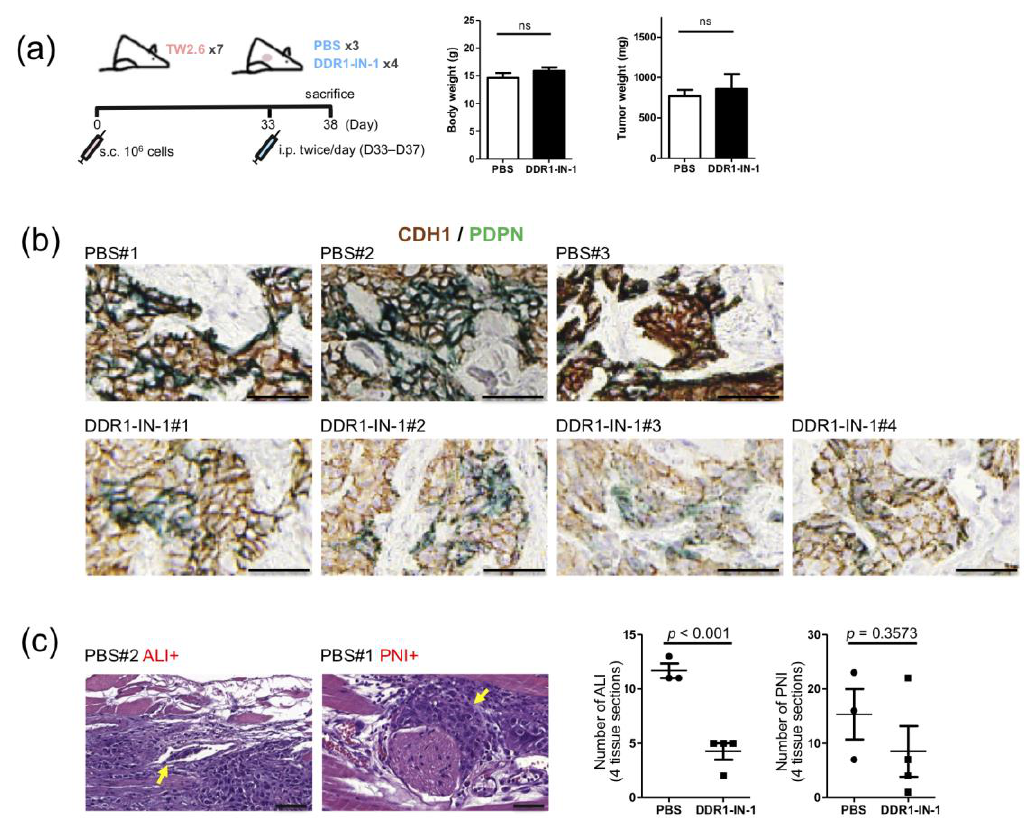
Figure 7. Suppression of collective TW2.6 cell invasion by DDR1-IN-1 in vivo. ( a ) (left) Schematic workflow of animal study. (right) Box plots show neither body weight nor tumor weight of mice in the control (PBS) and DDR1-IN-1 groups is statistically di ff erent. ( b ) Representative immunohistochemistry images of indicated TW2.6 xenograft tissues stained for CDH1 (brown) and PDPN (green). ( c ) Representative hematoxylin and eosin (H&E) stained xenograft sections with angiolymphatic invasion (ALI + ) or perineural invasion (PNI + ). Scale bars, 50 µ m. Quantitative comparisons of ALI / PNI between PBS and DDR1-IN-1 mice are summarized on the right.